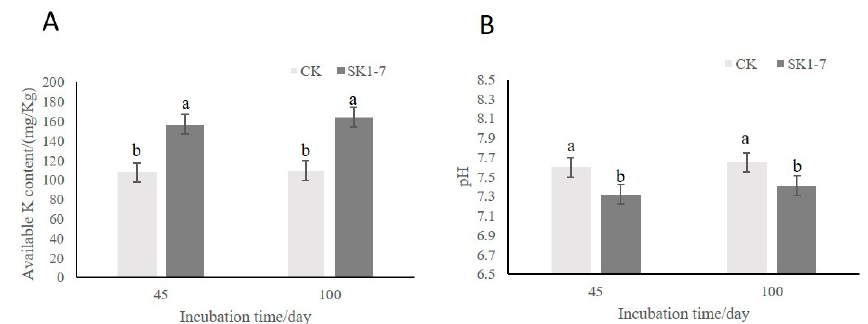
Figure 4. Soil pH and available potassium effects of applying B. aryabhattai SK1-7 to soil. CK: added with LB medium and water. SK1-7: inoculated with strain B. aryabhatta. ( A ) Effects of the SK1-7 strain on available potassium contents in poplar rhizosphere soil. ( B ) Effect of the SK1-7 strain on the pH of poplar rhizosphere soil. Different letters above the bars indicate significant differences ( p < 0.05).